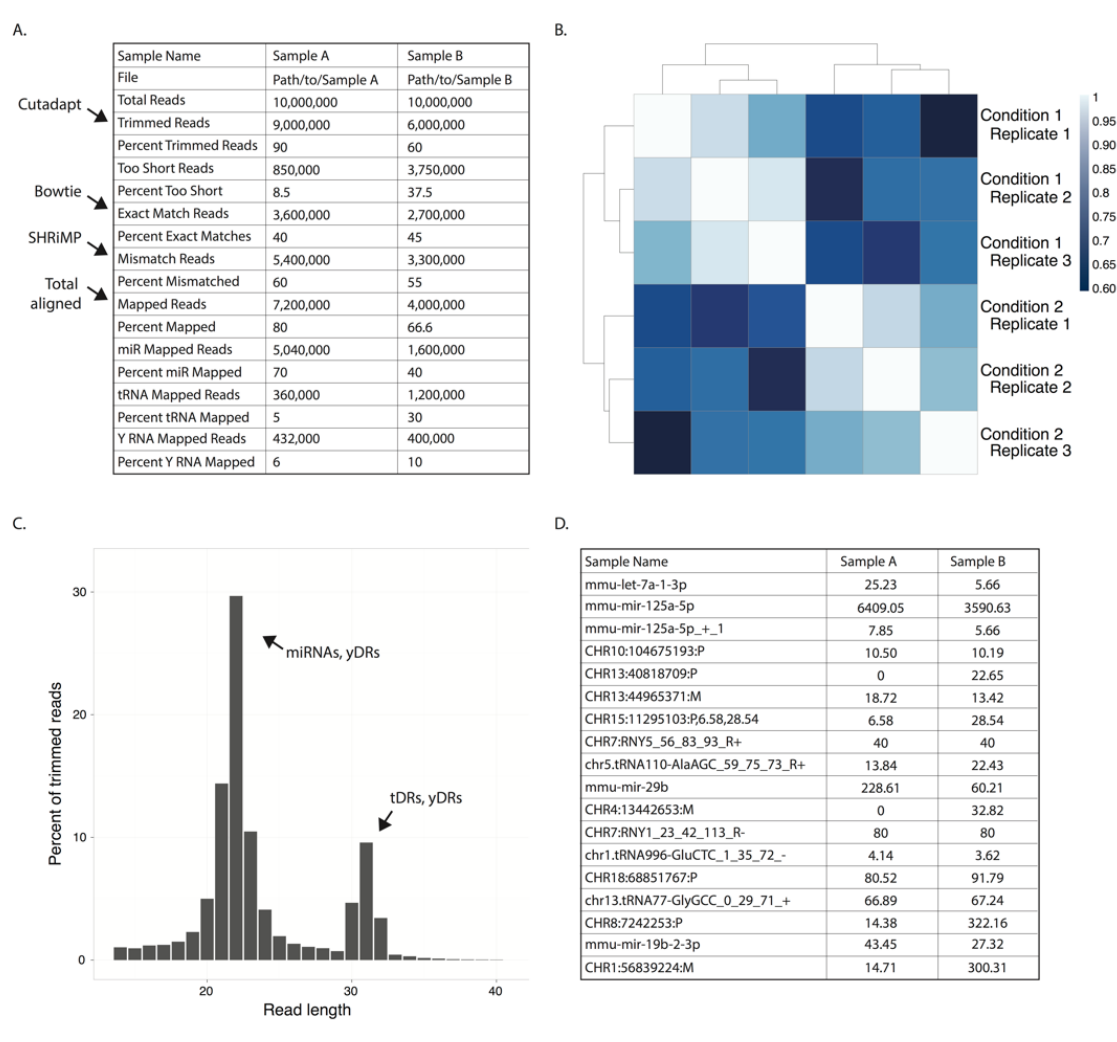
Figure 2: Summary of miRquant 2.0 output. Example output from running miRquant 2.0 on simulated data is shown. (A) Mapping statistics for two samples, A and B, are shown. The specific step in the miRquant 2.0 workflow at which a particular statistic is generated is indicated on the left. Sample A is an example of high-quality data, whereas B is an example of lower-quality data (e.g., lower rate of trimming). (B) miRNA expression correlation heat map for two different conditions with three replicates each is shown. The color of each square represents pair-wise Pearson correlation values. The dendrogram (relationship across samples) is determined by hierarchical clustering. (C) The length distribution of trimmed reads for a single sample is shown. The x-axis represents read length and the y-axis represents the percent of the total reads remaining following Cutadapt trimming. tDRs, tRNA-derived RNAs; yDRs, Y-RNA derived RNAs. (D) Reads per million mapped (RPMM) data for two different samples. Examples of possible annotations (miRNAs, isomiRs, tDRs, yDRs, and unannotated) are provided in column 1. The RPMM values are provided in columns 2 (Sample A) and 3 (Sample B). Additional data provided by miRquant, such as qualitative and quantitative information on